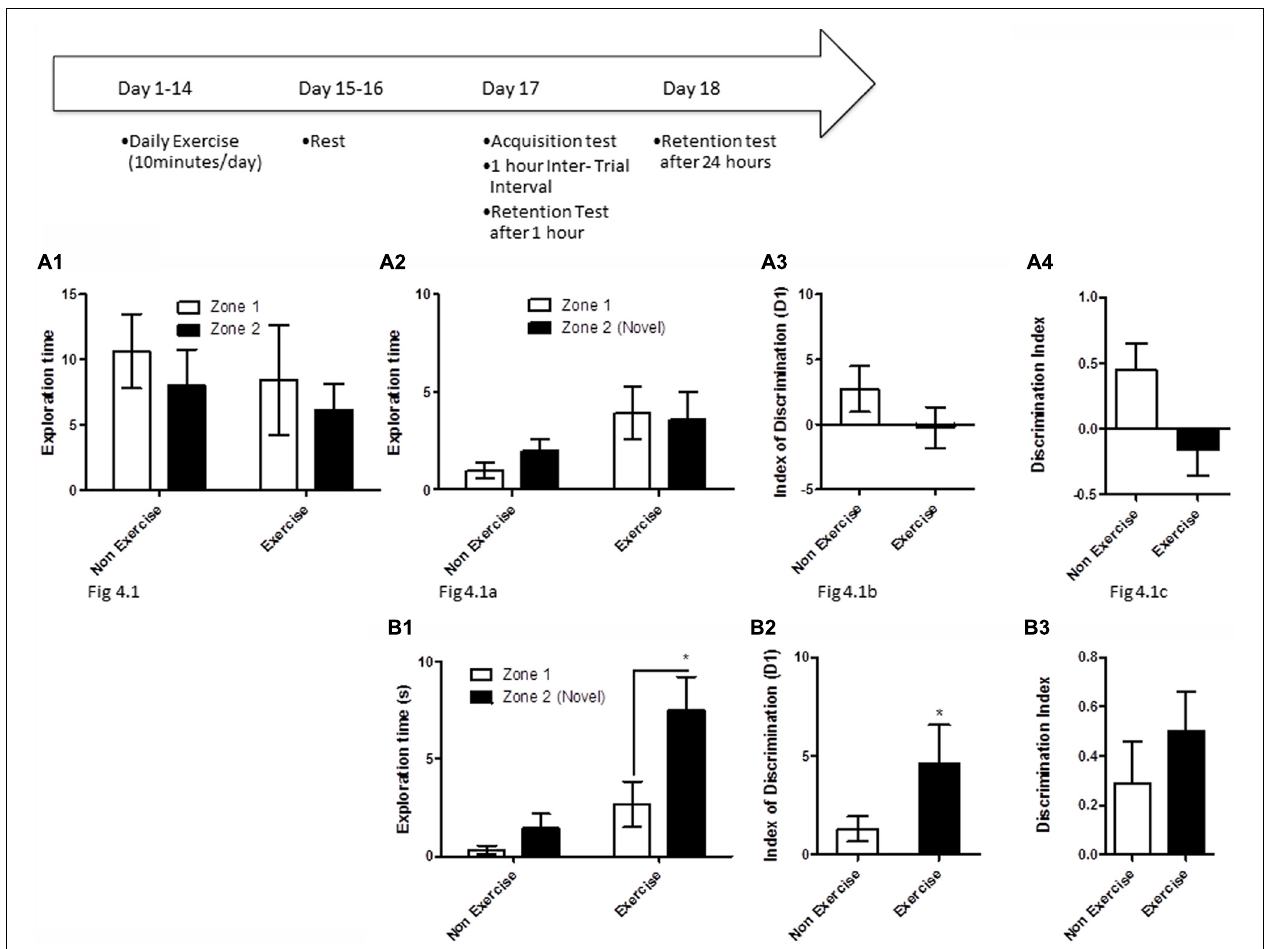
discriminate between the novel and familiar location. (A3) The index of discrimination also did not show any significant difference between the two group, 1 h after the exercise. (A4) Discrimination index also did not show any significant difference between the two groups, 1 h after exercise. n = 6–8/group. Error bars show ± SEM. (B1) Twenty-four hours after the acquisition phase or 48 h after the last exercise session, the exercise group showed greater exploration of the novel location compared to control group. (B2) The index of discrimination showed a significant difference between the two groups 24 h after acquisition. (B3) Discrimination index did not show any significant difference between the two groups, 24 h after acquisition. p < 0.05. *Significant difference between exercise and control group, with only the animals in the exercise group successfully discriminating between the novel and familiar locations. Error bars show ± SEM. n =